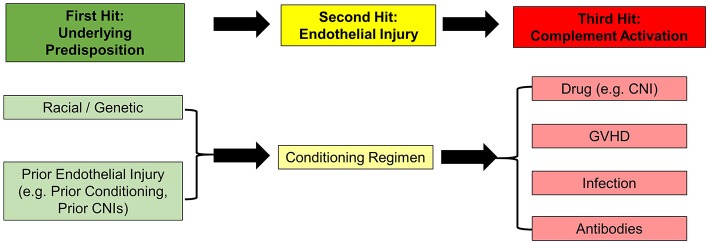
The “Three-Hit” hypothesis for the development of TA-TMA.